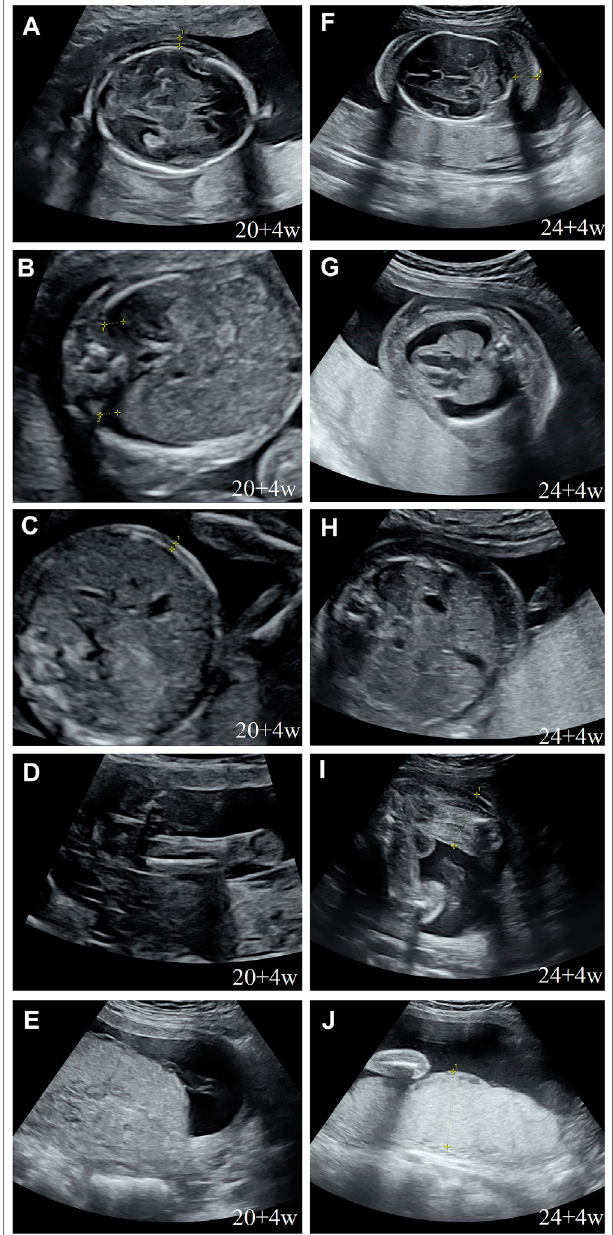
FIGURE 1 | Prenatal ultrasound. (A) Thalamus transverse section: subcutaneous edema: 3 mm; (B) thorax transverse section: bilateral hydrothorax: 4 mm; (C) abdominal transverse section: no subcutaneous edema; (D) sagittal sectionofthethigh:nosubcutaneousedema; (E) noplacentalthickening; (F) cerebellum transverse section: subcutaneous edema: 14 mm; (G) thorax transverse section: subcutaneous edema: 10 mm, bilateral hydrothorax: 10 mm, andlungcollapse,heartpressed; (H) abdominaltransversesection:subcutaneous edema: 10 mm; (I) sagittal section of the thigh: subcutaneous thickening: 9 mm; and (J) placental thickening: 53 mm.